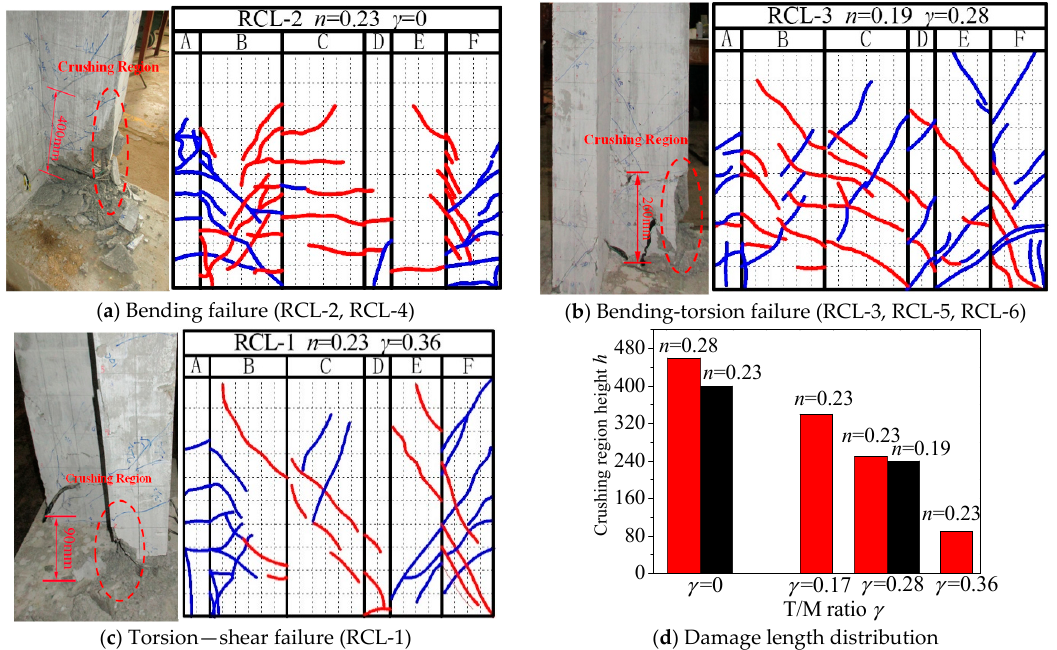
Figure 6. The failure pattern and cracks distribution